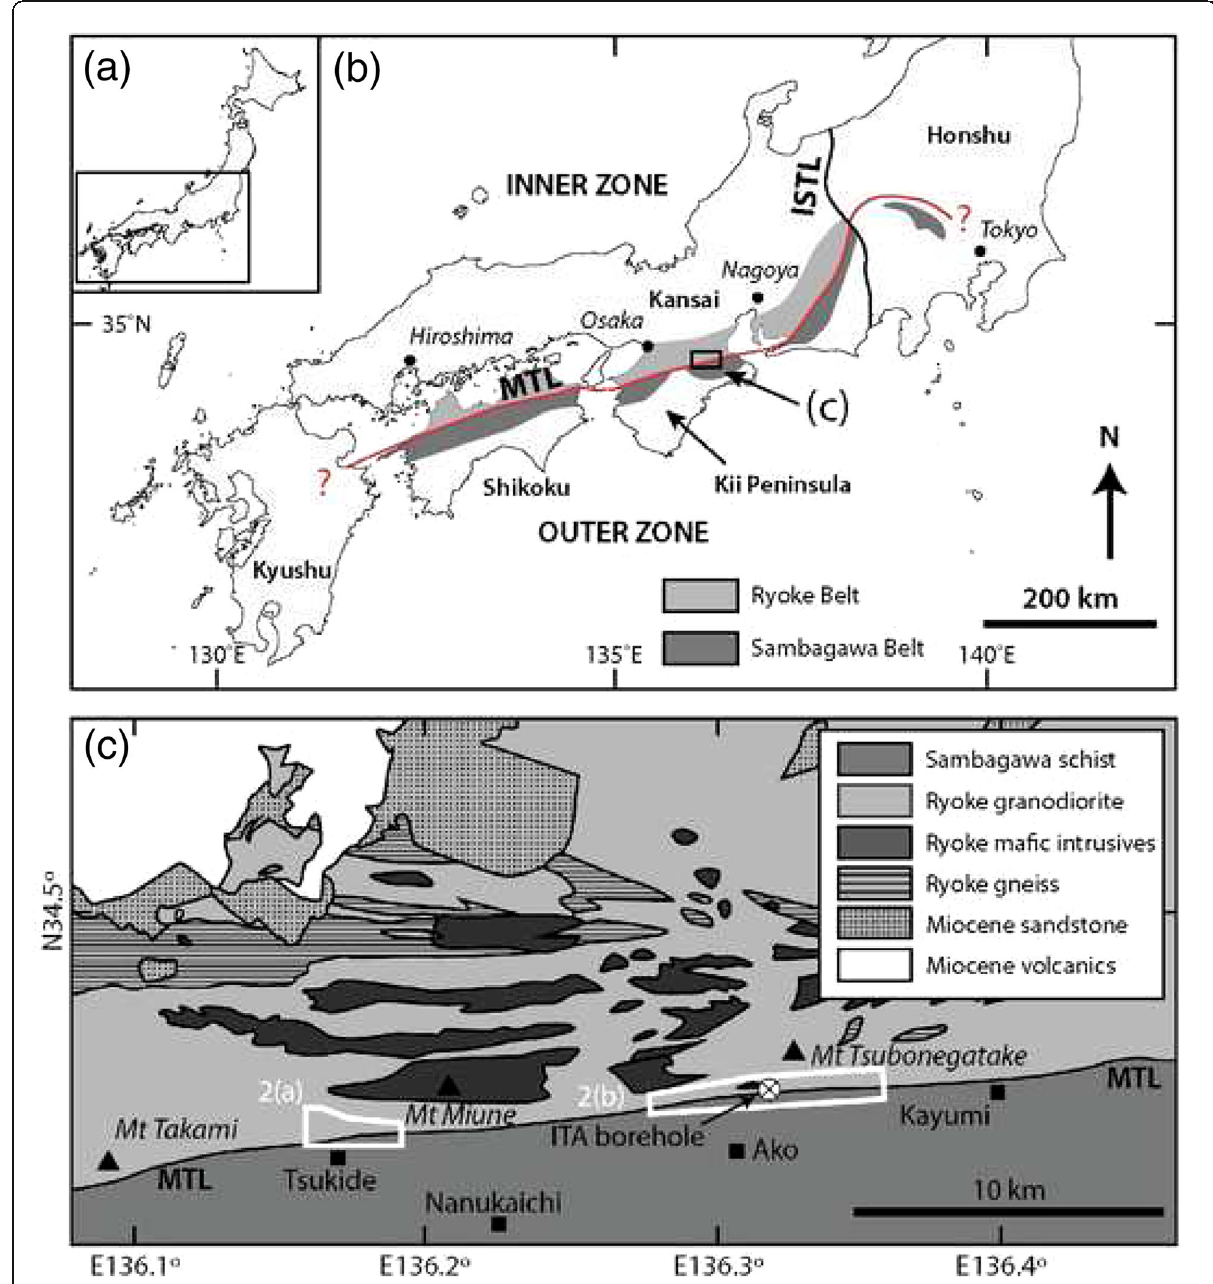
Fig. 1 ( a ) Location of the Median Tectonic Line (MTL) in SW Japan. ( b ) The MTL in Honshu and Shikoku, which separates the Ryoke belt (and Izumi Group) from the Sambagawa belt. ( c ) Location of the study area in the eastern Kii Peninsula, within the Kansai region. (Source: Geological Survey of Japan web page